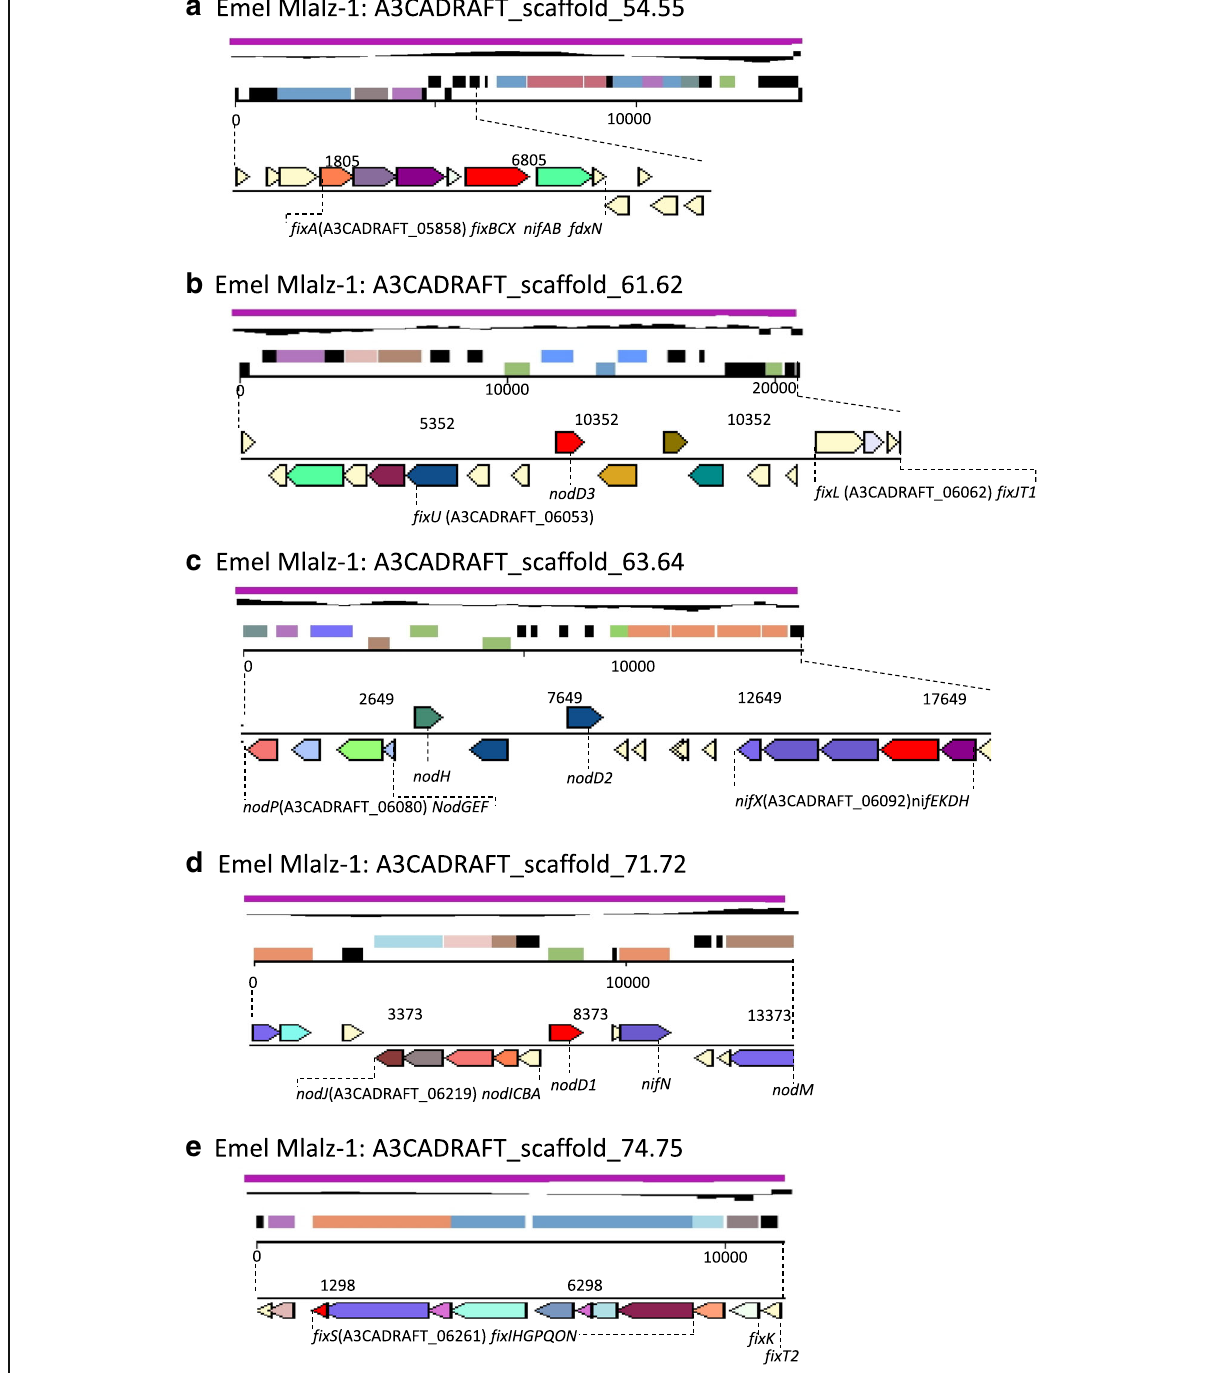
Fig. 5 Graphical map of the scaffolds; a A3CADRAFT_scaffold_54.55, b A3CADRAFT_scaffold_61.62, ( c ) A3CADRAFT_scaffold_63.64, d A3CADRAFT_scaffold_71.72 and e A3CADRAFT_scaffold_74.75 of Ensifer meliloti Mlalz-1 showing the location of common nodulation ( nod ) and fixation ( nif and fix ) genes within the symbiotic regions of this strain. From bottom to the top of the scaffold map: Genes on reverse strand (color by COG categories as denoted by the IMG platform), genes on forward strand (color by COG categories), RNA genes (tRNAs green, sRNAs red, other RNAs black), GC content, GC